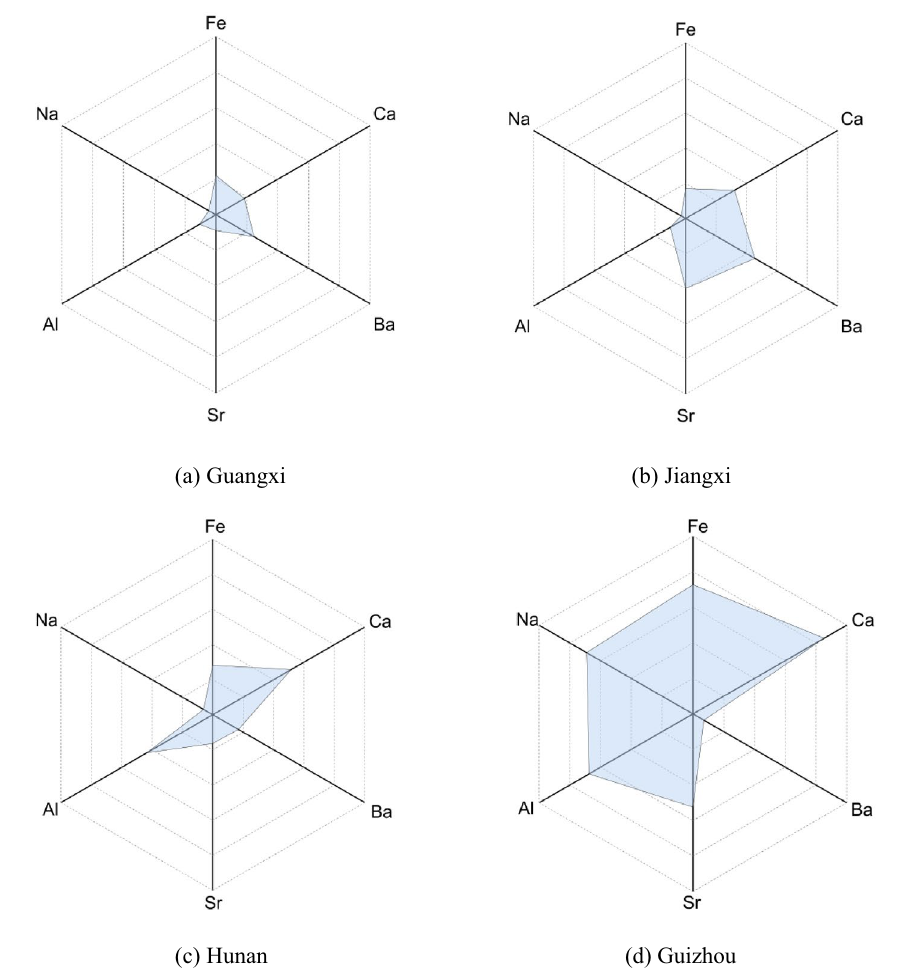
Figure 1. Radar plots showing the difference of geographical origins according to contents of elements (Na, Al, Sr, Ba, Ca, and Fe) in various LHG